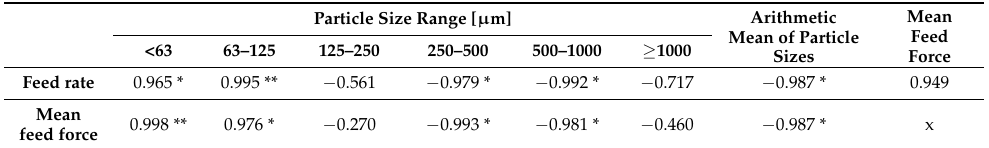
Table 1. Pearson’s correlation coefficients (** denote the highest correlation, *—other statistically significant at the level of significance α =